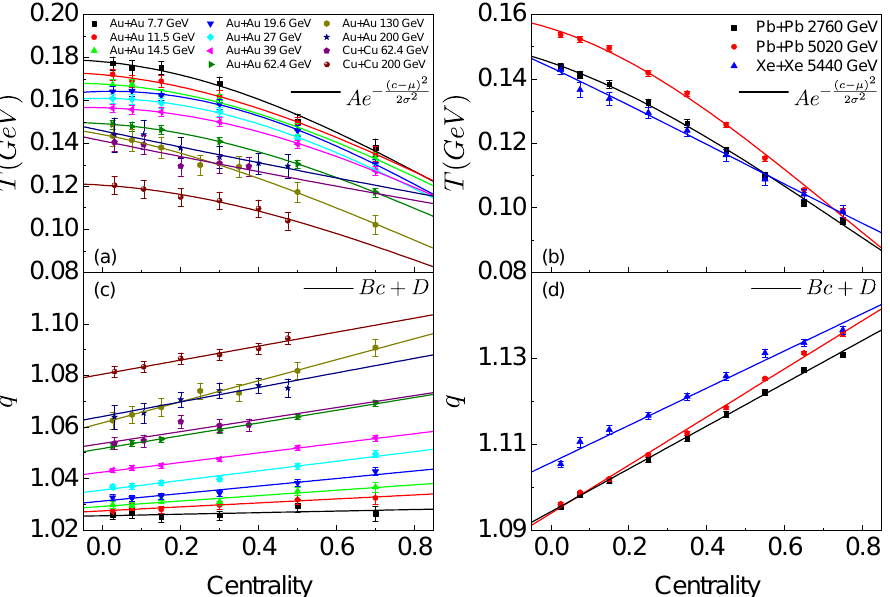
Figure 4. (Color online) The centrality (0 represents the most central collisions) dependence of the T √ s NN = 7.7 − 200 GeV, Cu + Cu collisions at and q in Au + Au collisions at √ s NN = 2.76, 5.02 TeV and Xe + Xe collisions at Pb + Pb collisions ( a , b ) are the parabolic fits and the lines in ( c , d ) are the linear